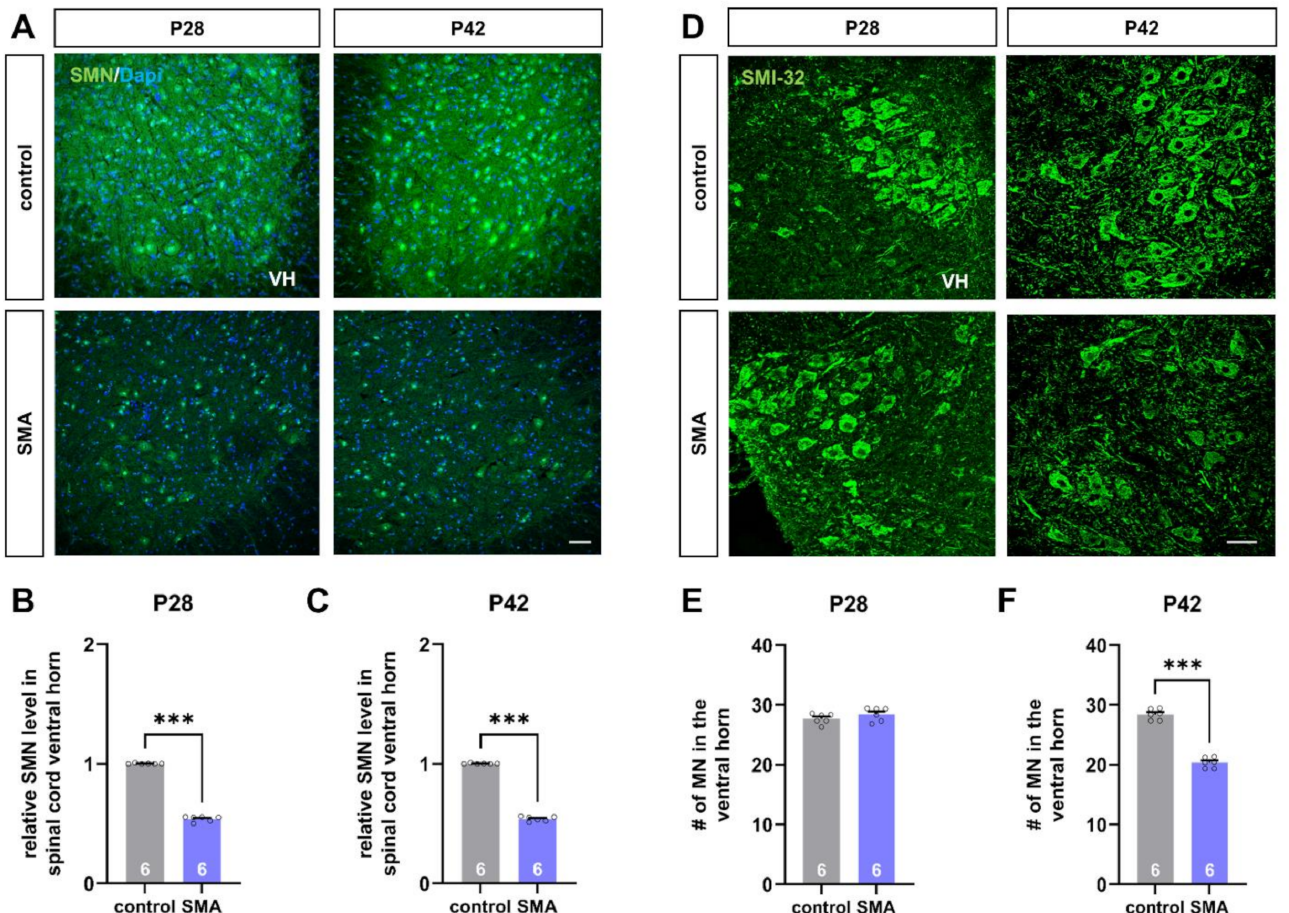
Figure 1. Deficiency of SMN protein and loss of spinal motor neurons in a mouse model of late-onset SMA. ( A ) Immunostaining of SMN protein (green) in spinal cord slices of control and SMA mice at P28 and P42. Nuclear DNA was stained with Dapi (blue). ( B , C ) SMN protein level was reduced in the spinal cord ventral horn of SMA mice at P28 and P42, compared to control mice at the same age (***, p < 0.001). ( D ) Immunostaining of spinal motor neurons (SMI-32, green) in spinal cord slices of control and SMA mice at P28 and P42. ( E , F ) The number of spinal motor neurons was reduced in SMA mice at P42, compared to control animals (***, p < 0.001). No loss of spinal motor neurons was observed at P28 ( p > 0.05). VH = ventral horn. n = 6 animals (see bars). Three slices per spinal cord were investigated. Each data point reflects the mean of those three spinal cord slices. Scale bar: A = 20 µ m; B = 50 µ